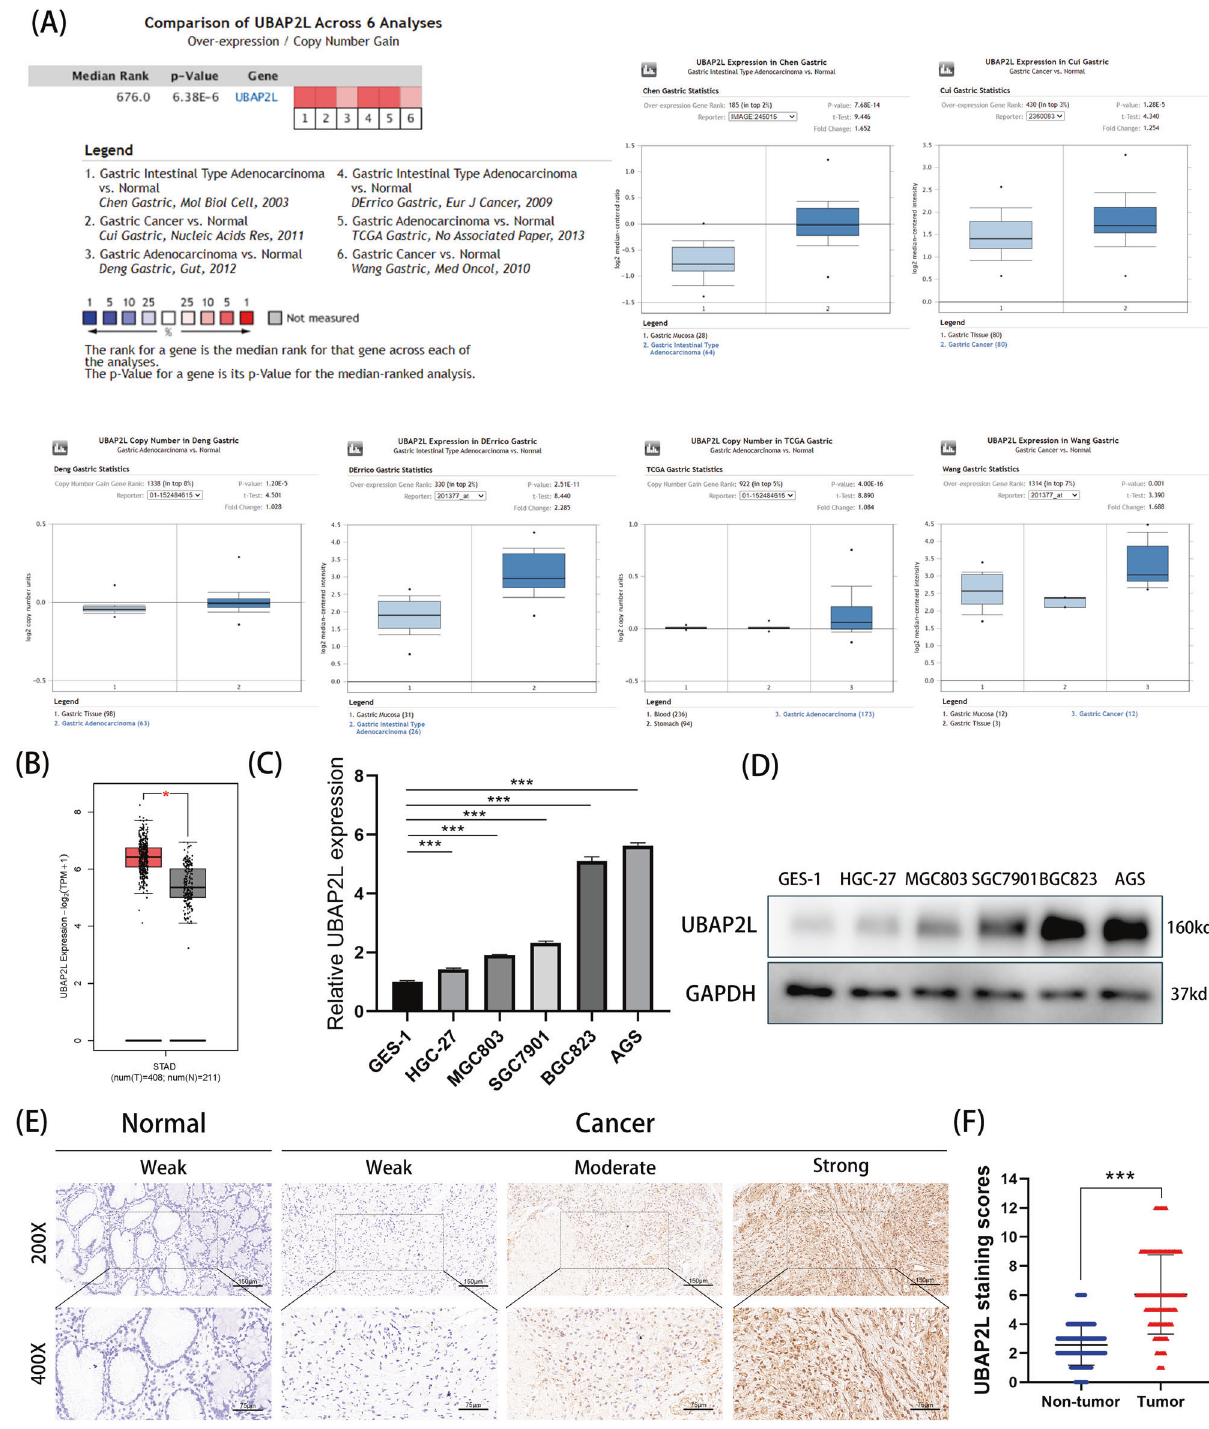
Fig. 1 UBAP2L is upregulated in gastric cancer. A Based on the Oncomine database, UBAP2L mRNA overexpression showed statistically signi fi cant in 6 datasets (red). B Relative UBAP2L expression in GC and adjacent normal tissue based on TCGA database. C , D Relative UBAP2L mRNA and protein expression in HGC-27, MGC03, SGC7901, BGC823, AGS, and GES-1 detected by quantitative real-time PCR and western blot. E Representative images of immunohistochemical staining for UBAP2L in GC tissue and adjacent normal tissues. F The score of immunohistochemical staining in 150 paired tumor and nontumor. immunohistochemistry. Among 150 GC tissues, 107 patients were expression of UBAP2L using qRT-PCR and western blotting. scored under the high expression group, whereas only 8 patients Consistent with the result of the aforementioned databases, the scored under the high expression group in the normal tissue expression of UBAP2L in the fi ve GC cell lines (Fig. 1C, D) was (Fig. 1E, F). These results suggest that UBAP2L expression is much much higher than that of GES-1. We also assessed the expression higher in GC tissues than in non-tumor tissues. of UBAP2L in 150 GC tissues and adjacent normal mucosa by Cell Death Discovery (2022)